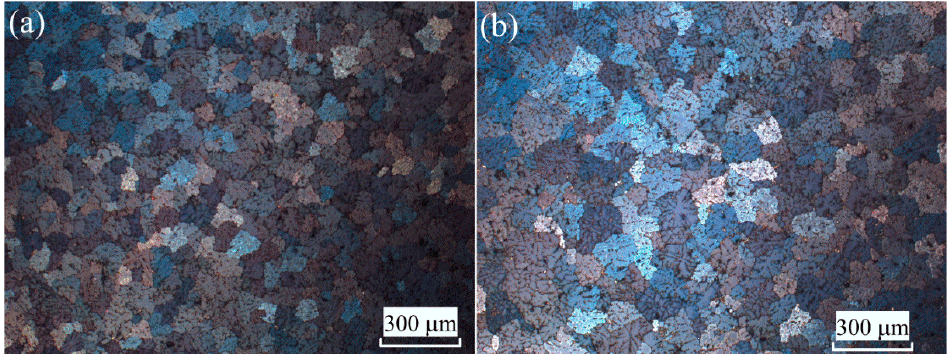
Figure 1. As-cast grain structures of the ( a ) AlCuYbMg and ( b ) AlCuGdMg alloys (OM). Prevue’s study was targeted at the structures and properties of the same alloys without Mg, Fe and Si impurities [19]. Al 80-88 Cu 8-12 Yb 3-4 Mn and Al 78-86 Cu 10-15 Gd 3-5 Mn phases of the solidification origin forms in the AlCuYbZrMn and AlCuGdZrMn alloys [24]. The same Mn-rich phases formed the eutectic microstructure in the investigated AlCuYbMg (Figure 2a,c) and AlCuGdMg (Figure 2b,d) alloys. In addition, Mn-rich phase particles with about 10% Mn were identified in the AlCuYbMg alloy. The formula of this phase can be written as Al 22 Cu 3 Mn 2 Yb. Similar Al 25 Cu 4 Mn 2 Y [22] and Al 25 Cu 4 Mn 2 Er [23] phases were identified in the microstructures of the AlCuYZrMn and AlCuErZrMn al- loys. Silicon impurity led to the Al 80 Yb 5 Cu 6 Si 8 and Al 80 Gd 5 Cu 8 Si 5 phase solidification in the AlCuYb [44] and AlCuGd [45] alloys. The volume fraction of the high Mn and Si-rich phases is very low (some peaks marked in the XRD patterns in Figure 2c,d). Magnesium in the investigated alloys led to the Mg 2 Si phase (black particles in Figure 2a,b) solidifi- cation. The as-cast composition of the Al solid solution is presented in Table 2.